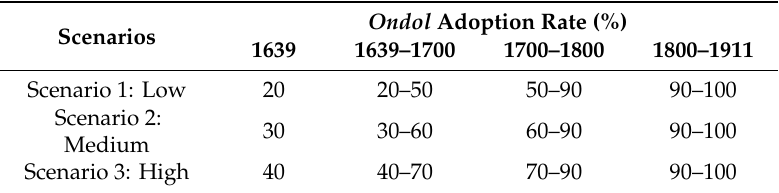
Table 1. Scenarios with di ff erent Ondol adoption rates.